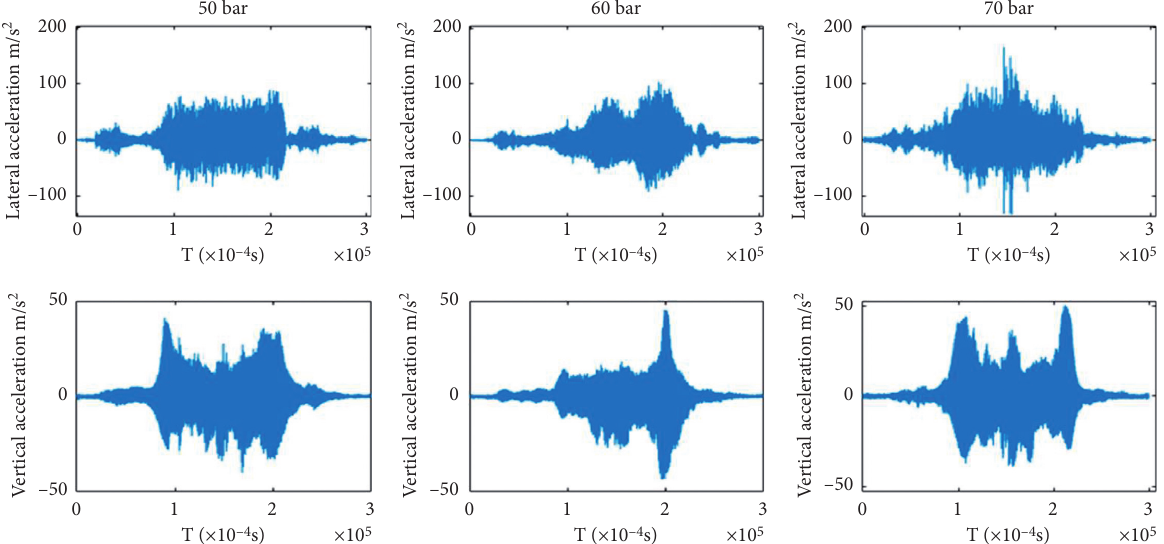
Figure 7: Comparison of acceleration of sleeper under different pressures.